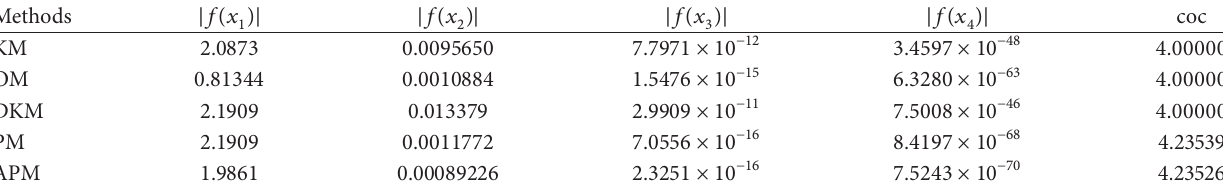
Table 2: Results of comparisons for Example